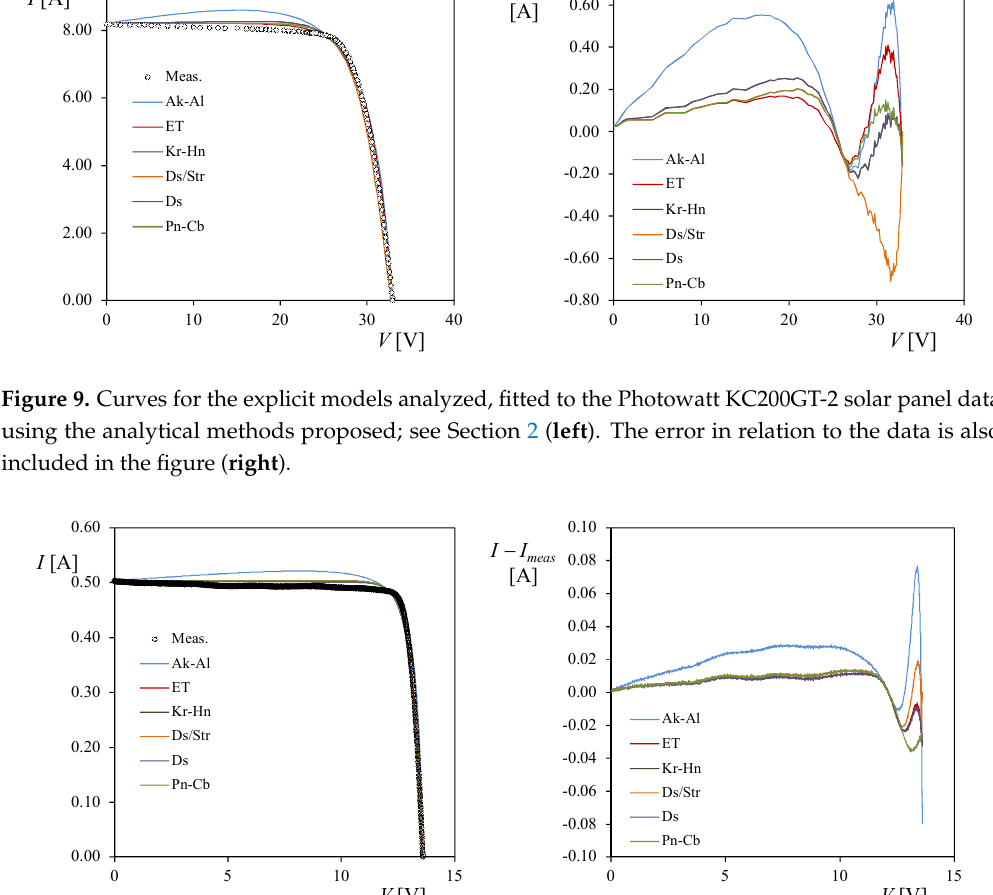
Figure 10. Curves for the explicit models analyzed, fitted to the Selex Galileo SPVSX5 solar cell